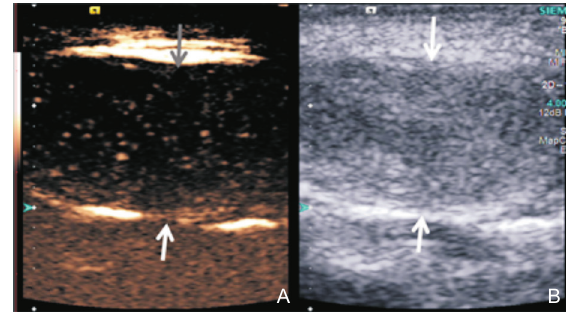
Figure 6 Malignant sentinel lymph node (arrows) in swine tumor model. (A) Contrast enhanced ultrasound image of the node with targeted microbubbles shows diffuse (42%) enhancement. (B) B-mode ultrasound image of the heterogenous node.